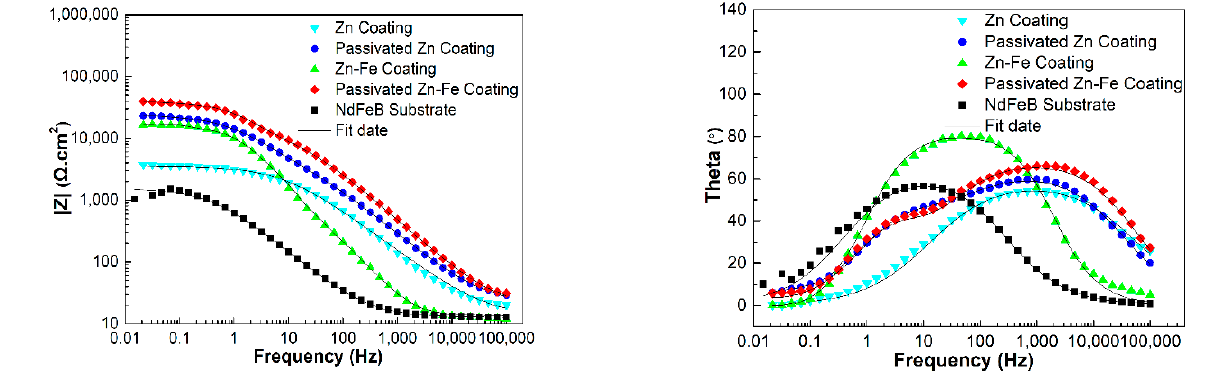
Figure 8. Bode impedance plots of different specimens in neutral 3.5 wt.% NaCl solution.